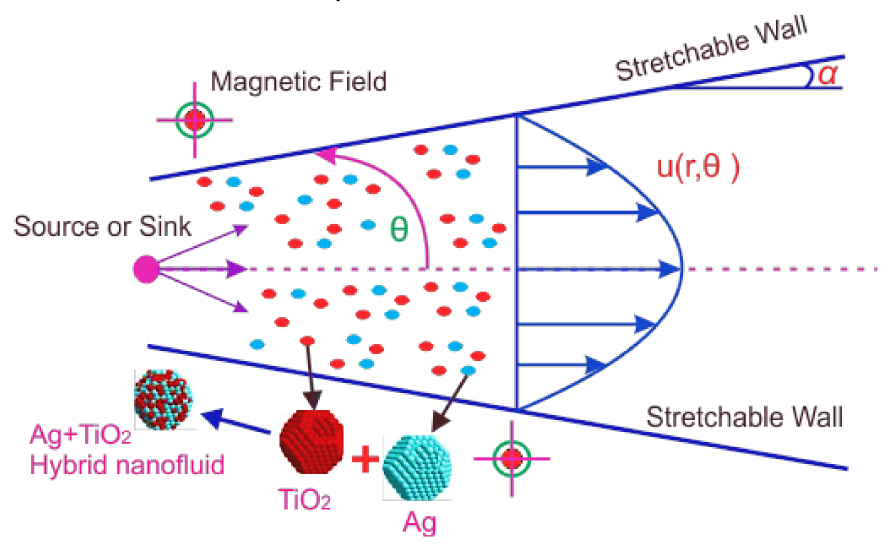
Figure 1. Geometry of the flow.